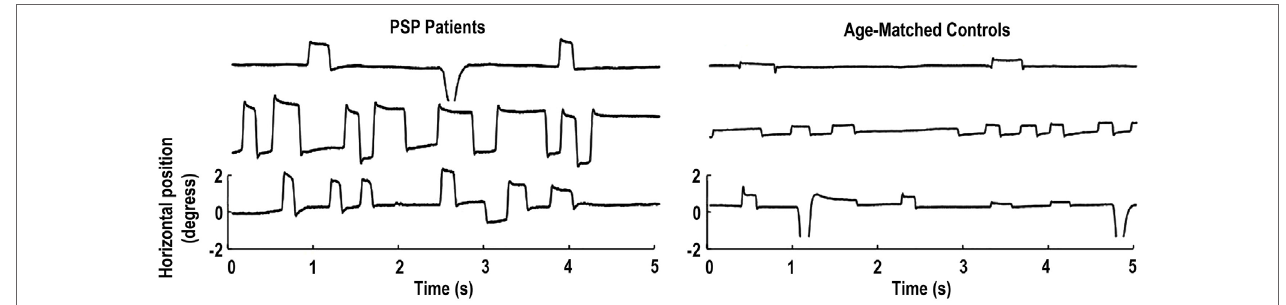
FigURe 1 | Square-wave jerks (SWJs) from three progressive supranuclear palsy (PSP) patients (left) and three age-matched controls (right). In both populations, (micro)saccades with amplitudes equal to or larger than half a degree of visual angle are paired as SWJs. Only the horizontal eye positions are shown. Modified from Otero-Millan et al.